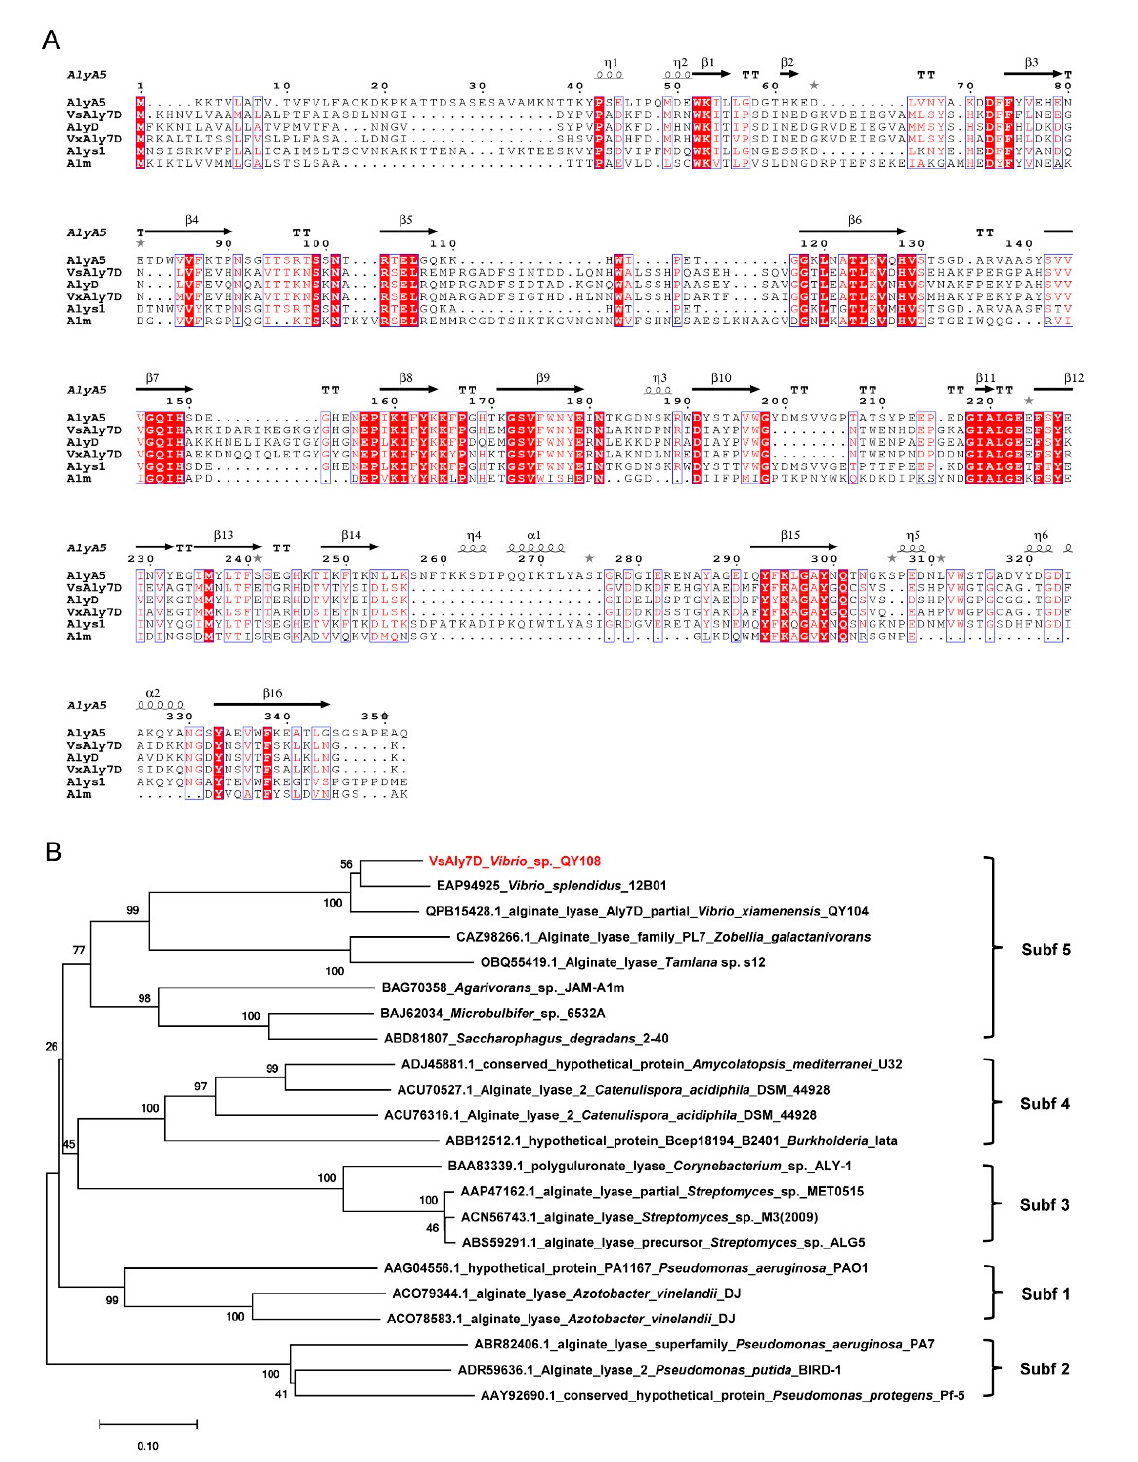
Figure 1. Multiple sequence alignment and phylogenetic analysis of VsAly7D. ( A ) Amino acid alignment of VsAly7D with several identified PL7 alginate lyases, including AlgA5 (CAZ98266) from Zobellia galactanivorans , VsAly7D from Vibrio sp. QY108 in this study, AlyD (EAP94925) from Vibrio splendidus 12B01, VxAly7D (QPB15428) from Vibrio xiamenensis , Alys1 (OBQ55419) from Tamlana sp. s12 and Alm (BAG70358) from Agarivorans sp. JAM-A1m. The asterisk indicate residues with 3D alternate conformations. Red backgrounds represent the same amino acid residues, and red fonts in blue boxes indicate amino acid residues with identity > 70%. ( B ) A phylogenetic analysis of VsAly7D with the other PL7 alginate